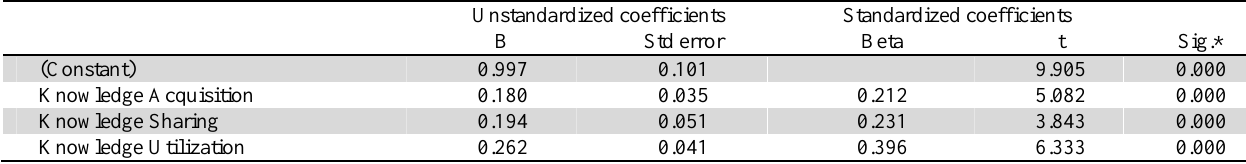
Regression equation- Team Learning and knowledge management Unstandardized coefficients